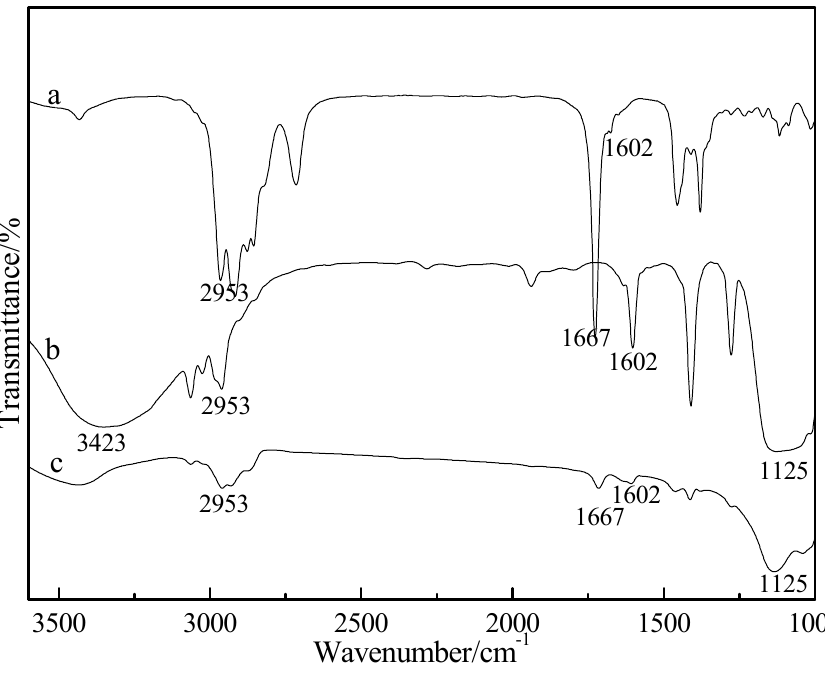
Figure 1. FTIR spectra of ( a ) citral, ( b ) VS and ( c ) VS ‐ citral.